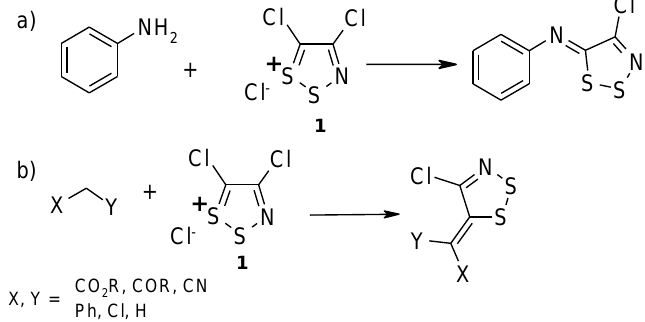
Figure 1. The ( Z )-3-(4-oxo-4,5-dihydro-thiazol-5-ylidene)indolin-2-one pattern ( I ) [26,27], and synthesis targets 3-(4-chloro-5 H -1,2,3-dithiazol-5-ylidene)indolin-2-one ( II ) and (2-oxoindolin-3-ylidene)-2-mercaptoacetonitrile ( III ).